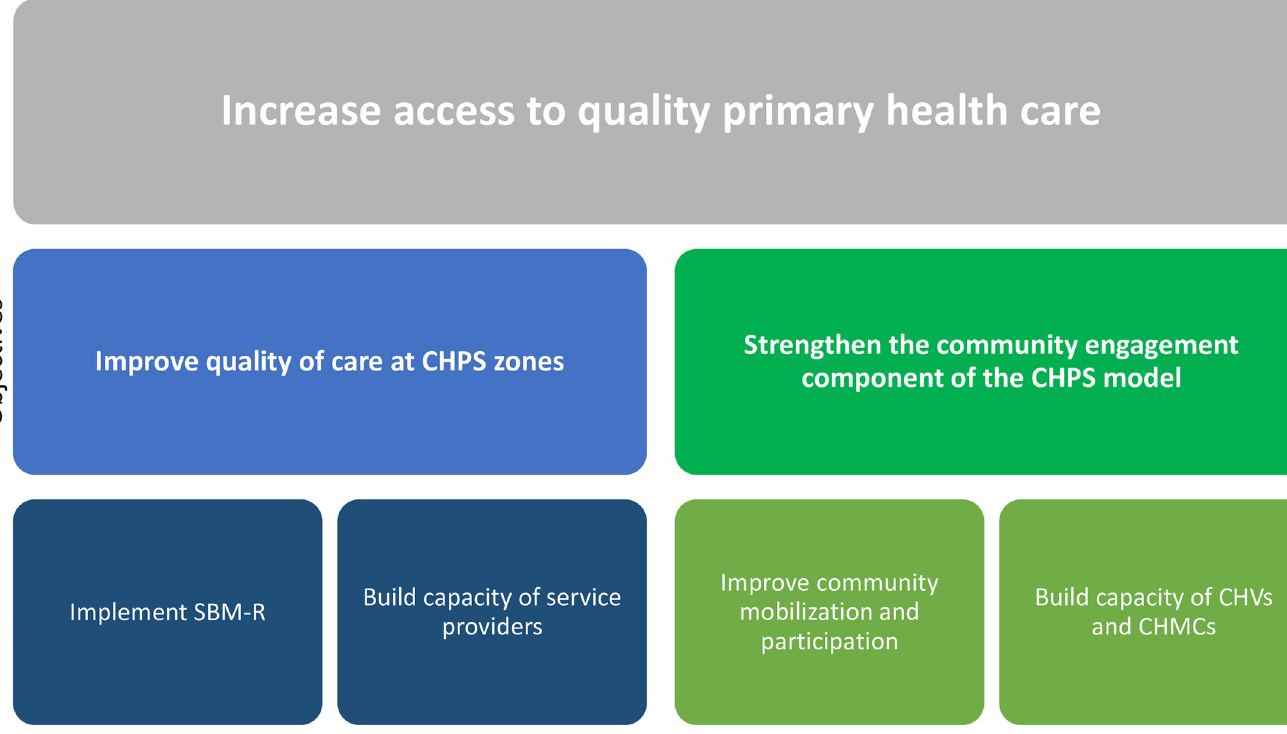
Fig 1. STAR CHPS project